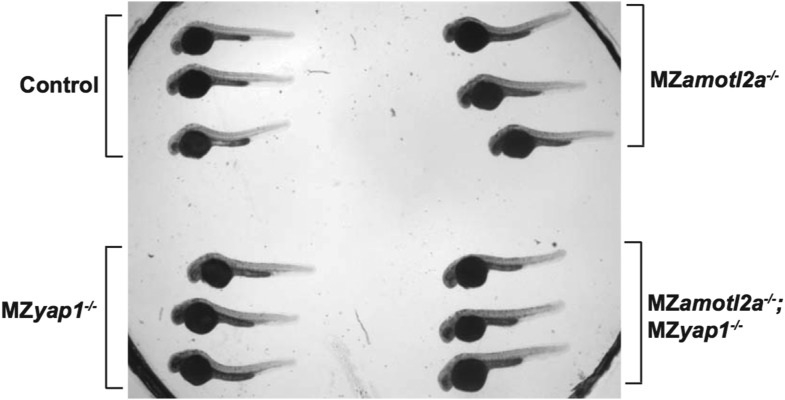
DOI:
http://dx.doi.org/10.7554/eLife.08201.045